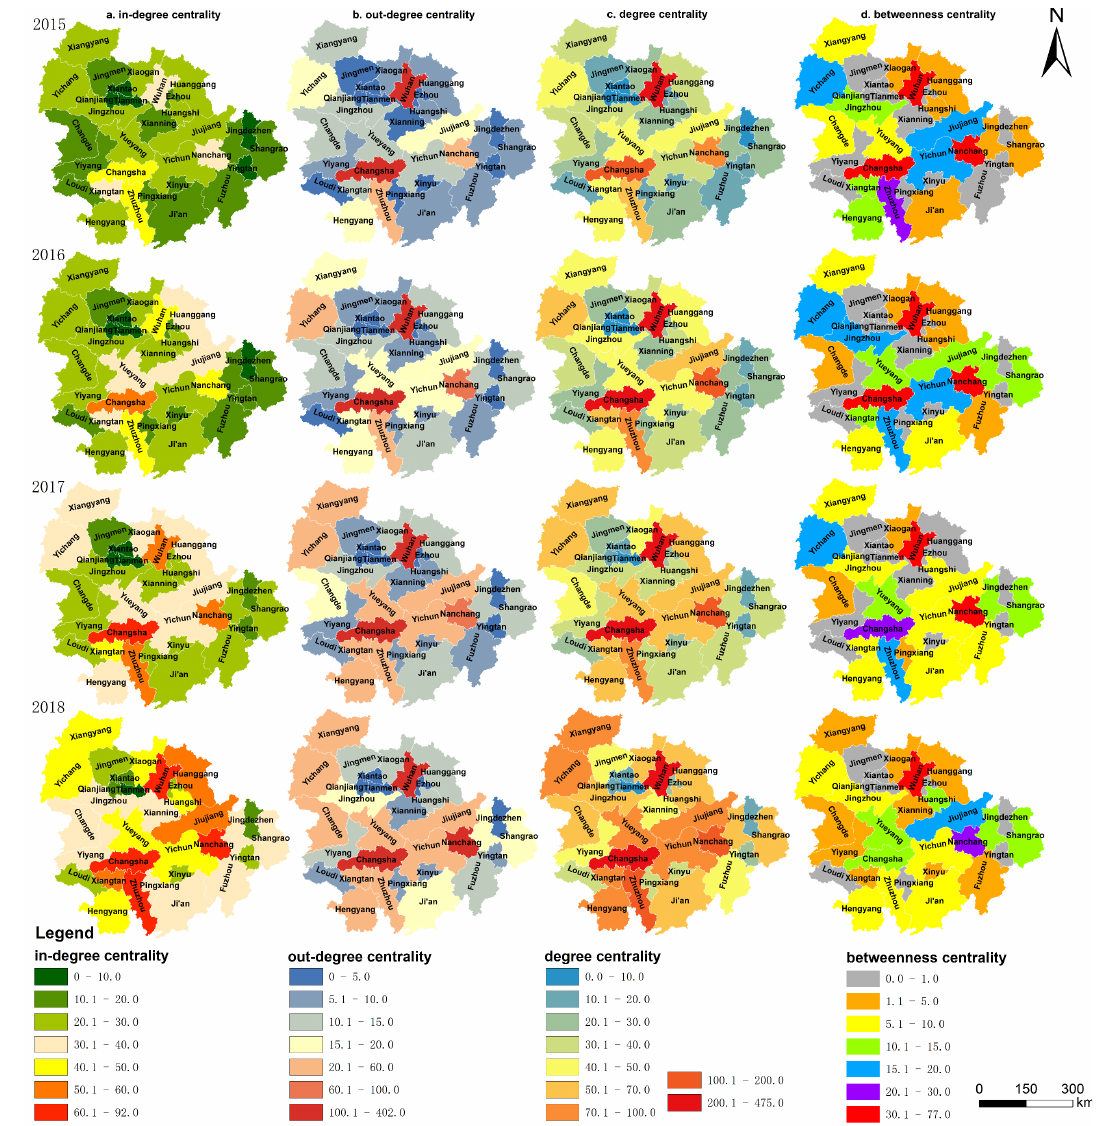
Figure 5. Centrality analysis results of innovation network in UAMRYR: ( a ) in-degree centrality; ( b ) out-degree centrality; ( c ) degree centrality; ( d ) betweenness